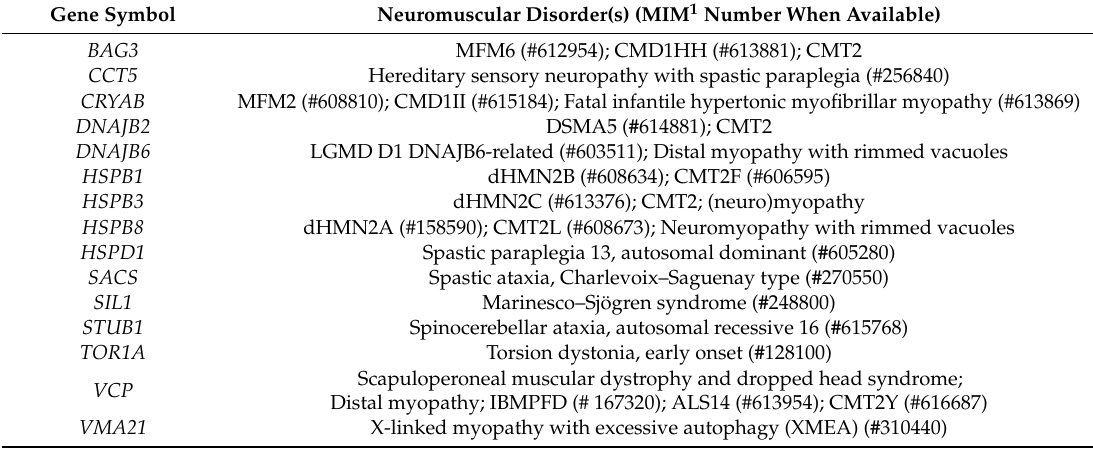
Table 1. Chaperone and cochaperone genes currently known to underlie neuromuscular disorders.